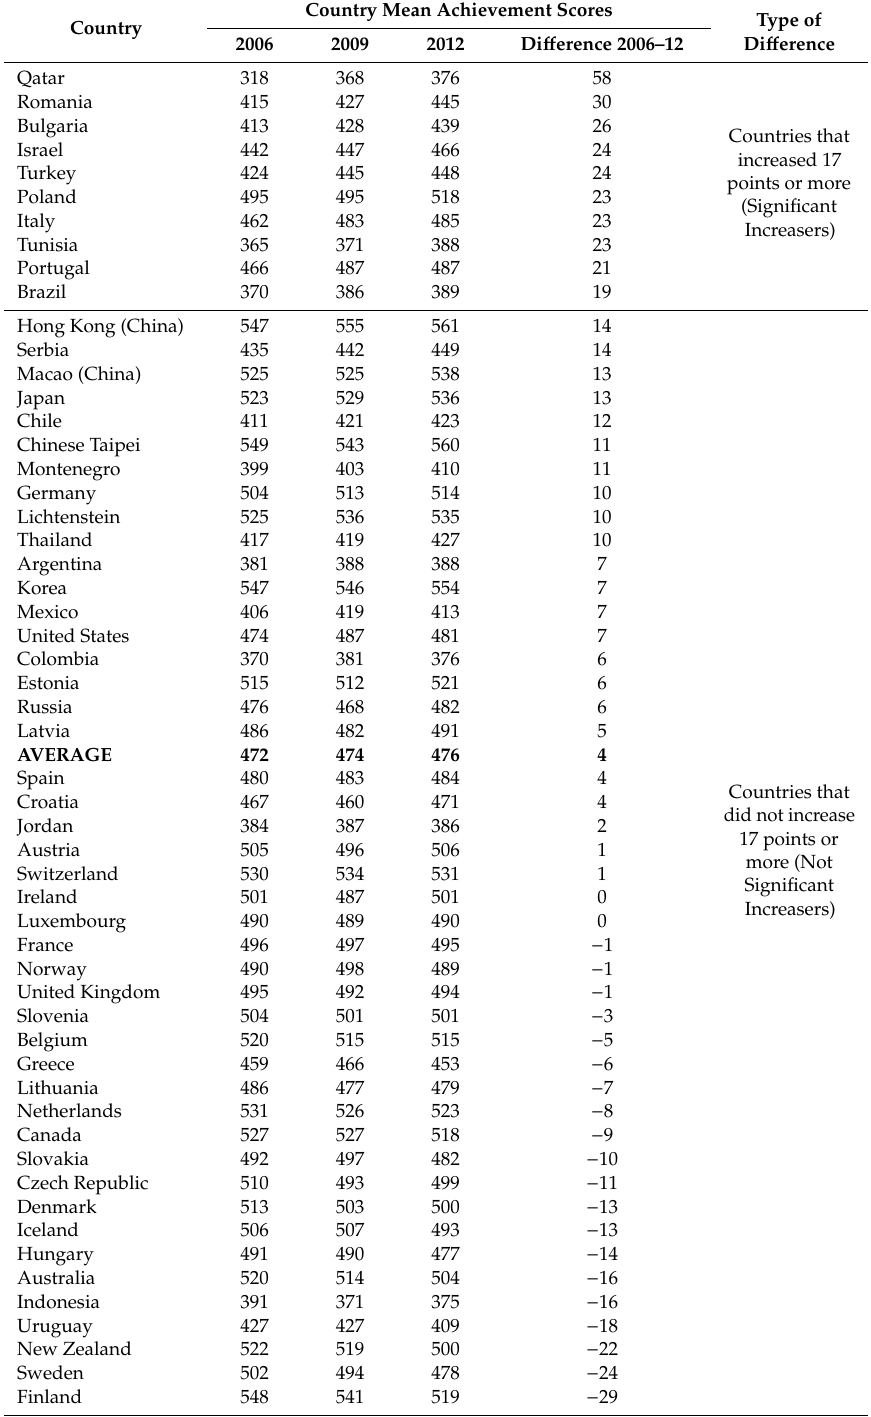
Table 2. PISA mathematics achievement scores and di ff erences by country, 2006–2012.